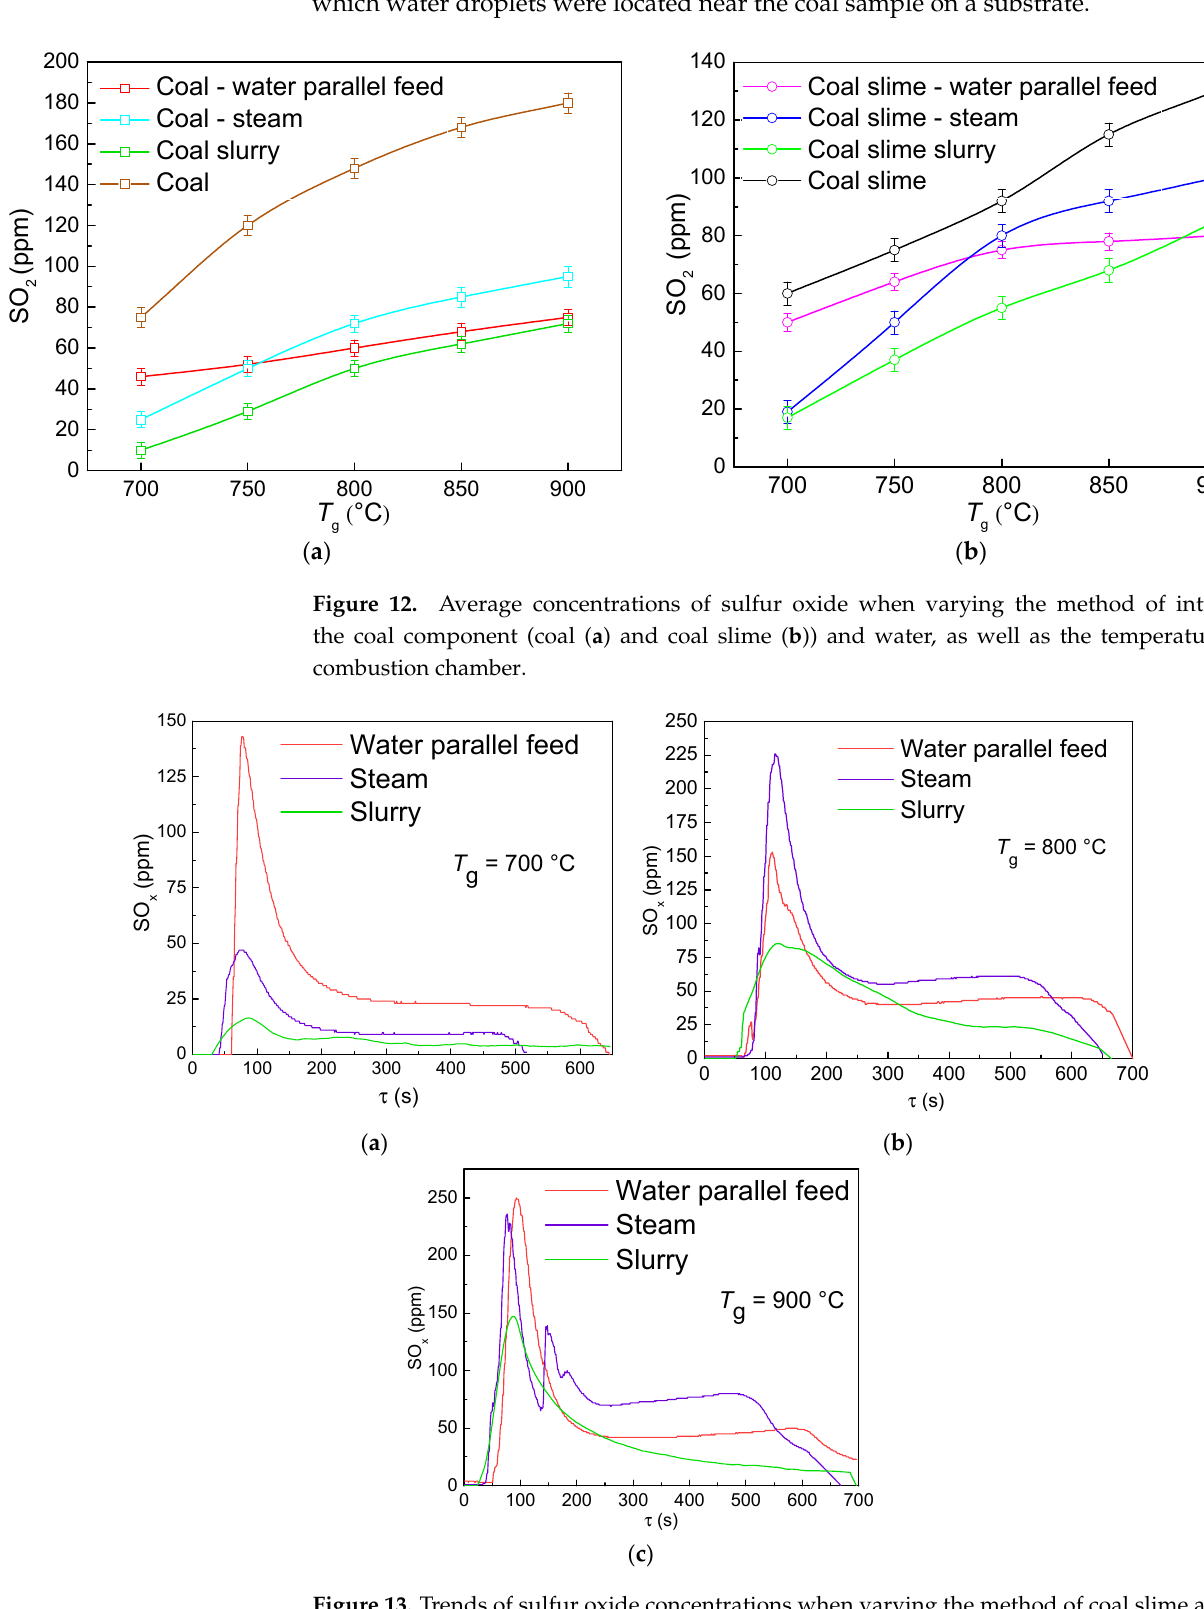
Figure 13. Trends of sulfur oxide concentrations when varying the method of coal slime and water introduction and temperature in the combustion chamber: ( a ) 700 °C; ( b ) 800 °C; ( c ) 900 °C.